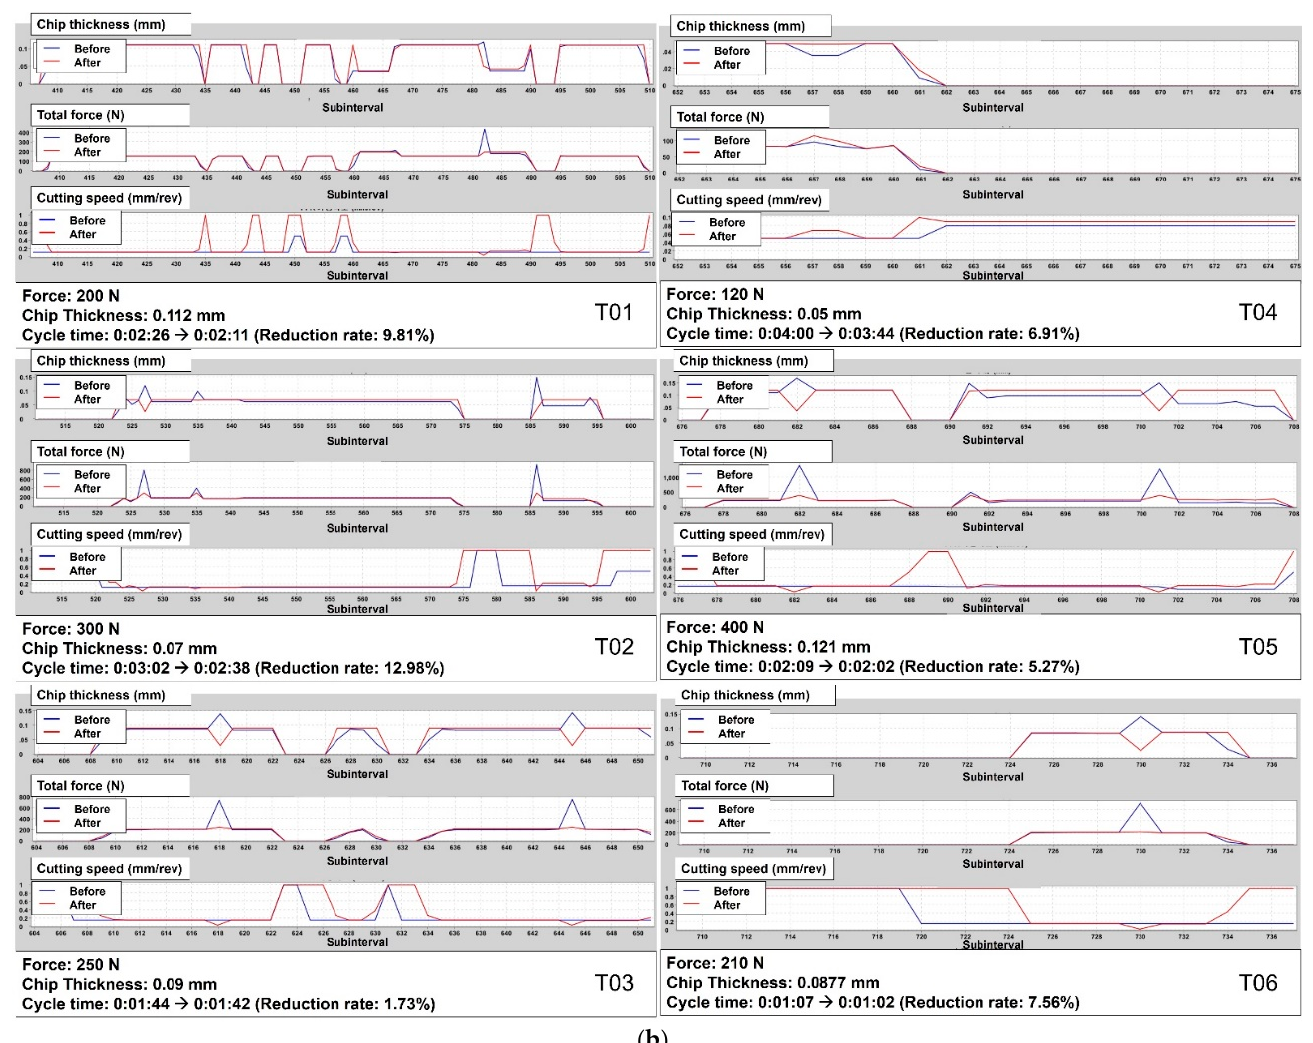
Figure 4. Comparison results and cycle times before and after feed optimization. ( a ) Semi-finishing; ( b ) finishing.